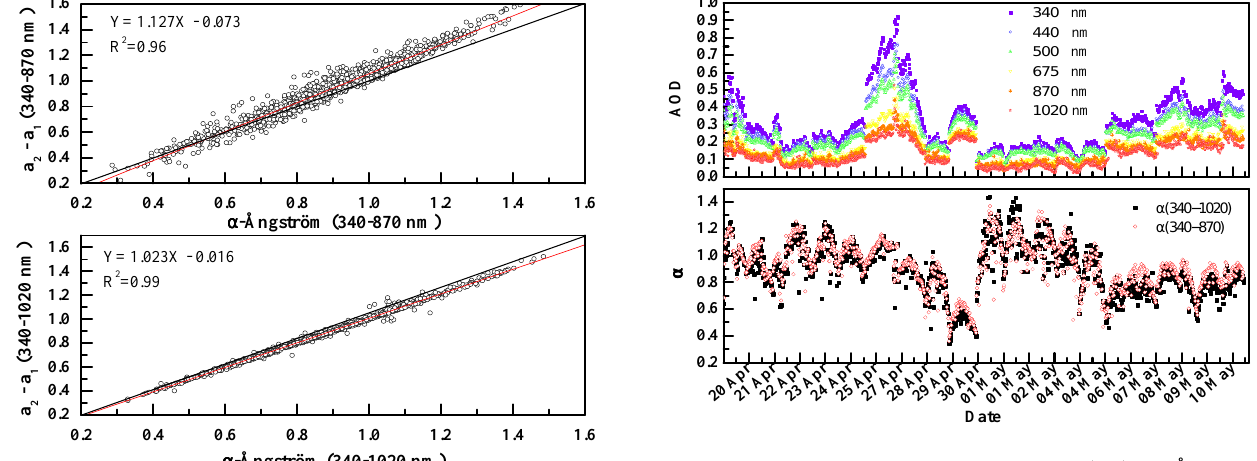
Fig. 6. Temporal variation of the spectral AOD (top) and ˚Angstr¨om exponent α in two different spectral bands, 340–1020nm and 340– 870nm (bottom) in the AS during the ICARB